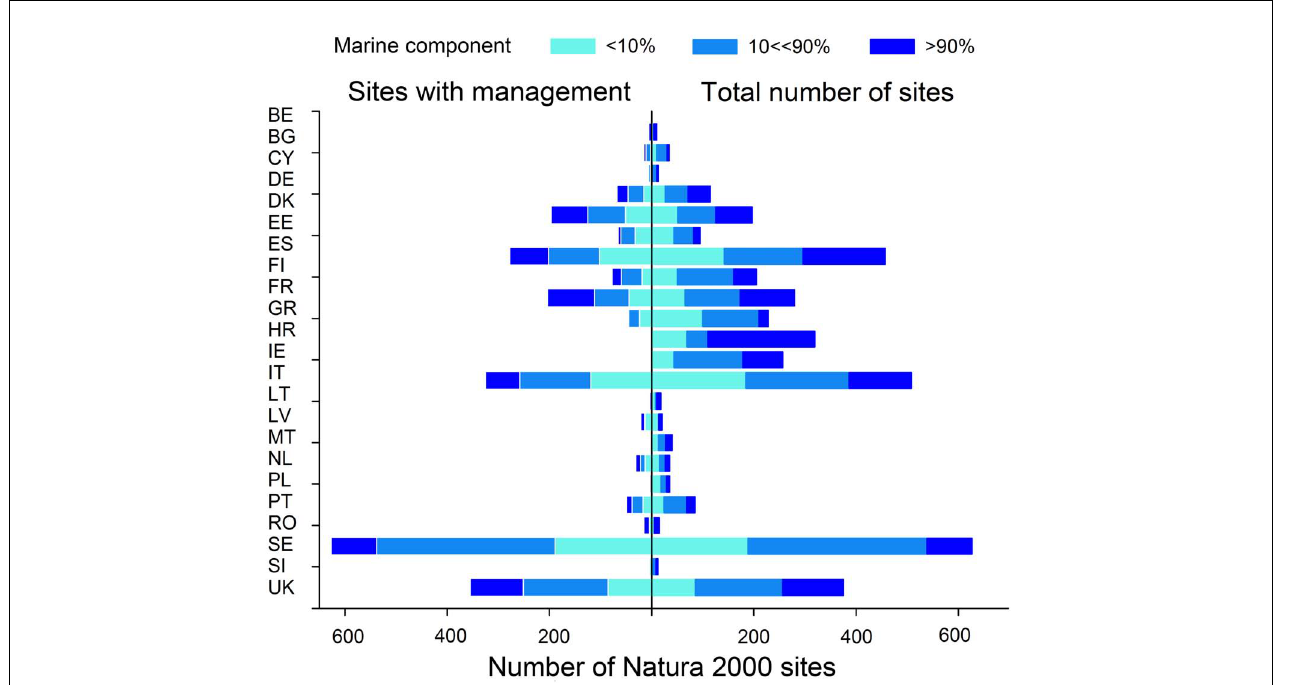
FIGURE 1 | Number of sites of the Natura 2000 network with a marine component in each country. The number of sites for which a management plan exists and/or official management and conservation measures are applied is also showed. The spatial borders of the Natura 2000 sites and information on site-based management plans and measures were retrieved from the official Natura 2000 database in the European Environmental Agency (EEA) website (accessed 27 October 2017). To identify the marine component of the sites, we used the digital terrestrial terrain of Europe, also retrieved from EEA (https://www.eea.europa.eu/data-and-maps/data/eea-coastline-for-analysis-1; accessed 27 October 2017). Country codes as follows: BE, Belgium; BG, Bulgaria; CY, Cyprus; DE, Germany; DK, Denmark; EE, Estonia; ES, Spain; FI, Finland; FR, France; GR, Greece; HR, Croatia; IE, Ireland; IT, Italy; LT, Lithuania; LV, Latvia; MT, Malta; NL, Netherlands; PL, Poland; PT, Portugal; RO, Romania; SE, Sweden; SI, Slovenia; UK, United Kingdom.